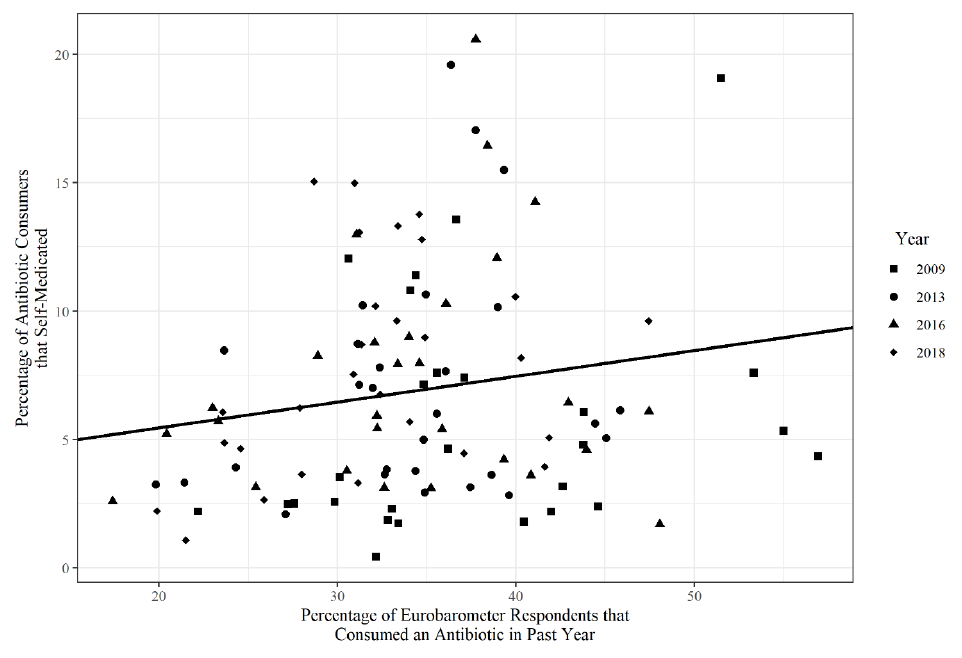
Figure 1: Antibiotic consumption against the level of self-medication among antibiotic consumers for